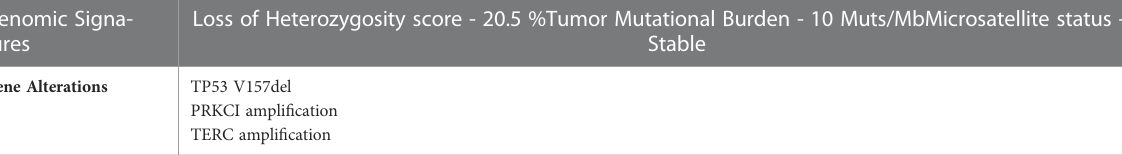
TABLE 1 Genomic alterations of patient A by FoundationOne ® CDx test. Genomic Signa-